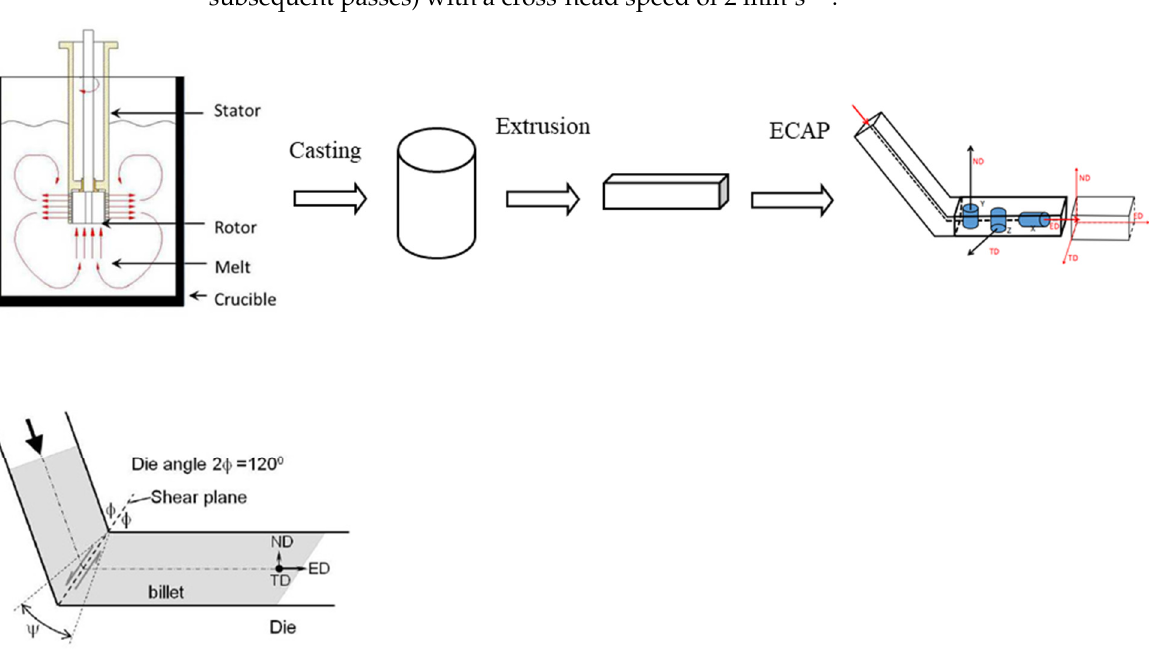
Figure 1. Schematic diagram of ( a ) the processing route of Mg-3Zn-0.2Ca alloy and 1 β -TCP/Mg-3Zn-0.2Ca composite; ( b ) the essential geometrical parameters for the ECAP die and specimen orientation nominations.